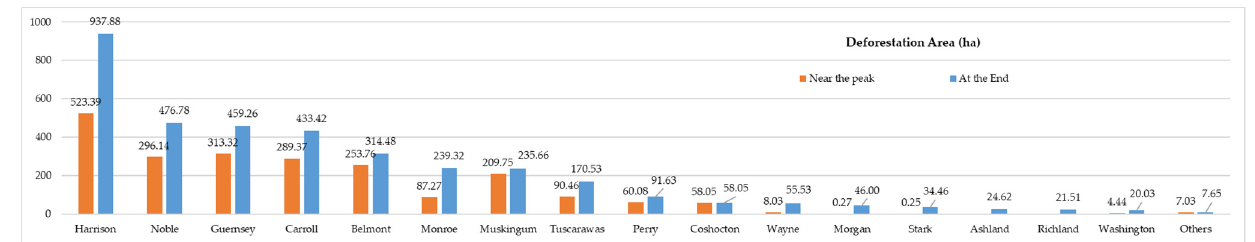
Figure 10. The deforestation area due to unconventional shale gas extraction activities in the top counties near the peak and at the end of the boom. Orange bars indicate the deforestation area from the start of the boom to the peak of the boom, while blue bars indicate the deforestation area from the start of the boom to the end of the boom.